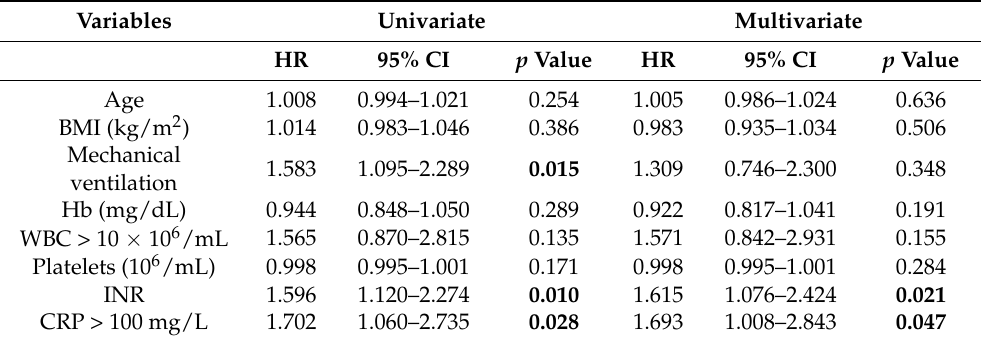
Table 6. Uni- and multivariate Cox regression analyses on day 3 within the entire study cohort with regard to 30-day all-cause